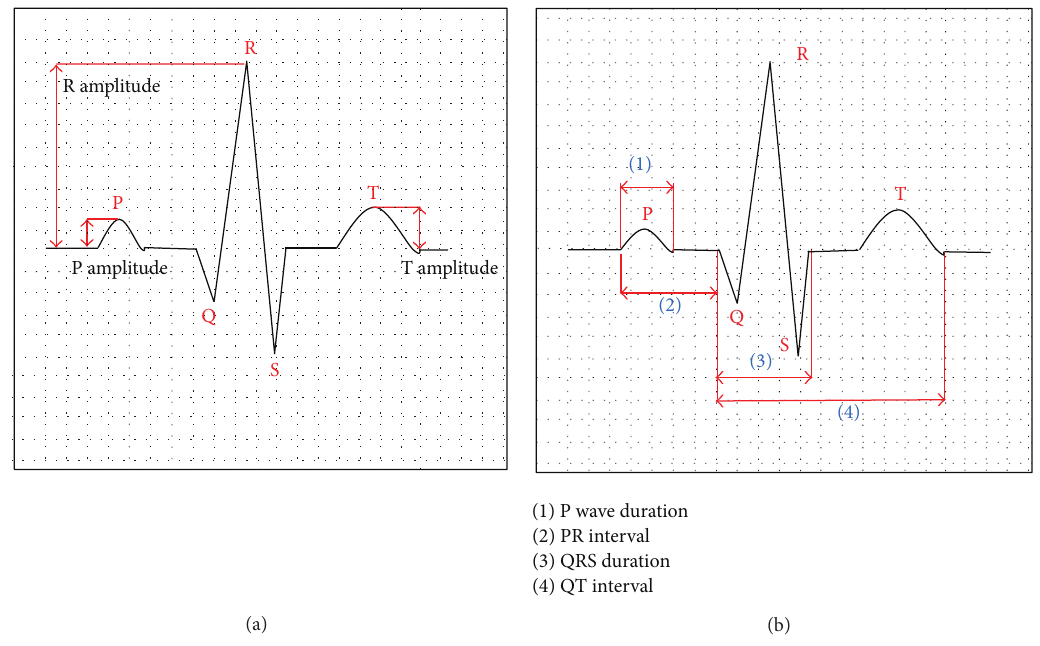
Figure 1: PQRST waveforms from an electrocardiography